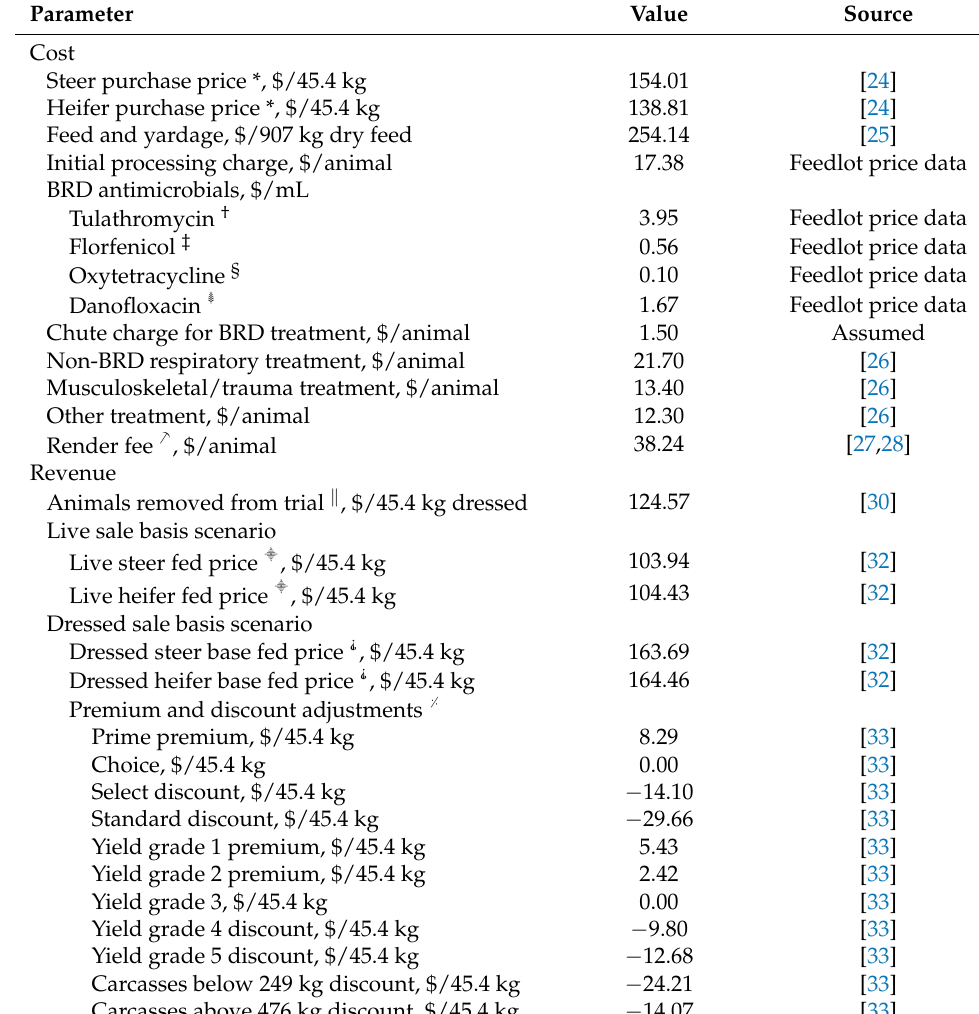
Table A3. Parameters and prices used in the partial budget assessment of pen-level outcomes of steers and heifers at medium risk for bovine respiratory disease (BRD) in a clinical trial comparing pull-and-treat or metaphylaxis health programs.